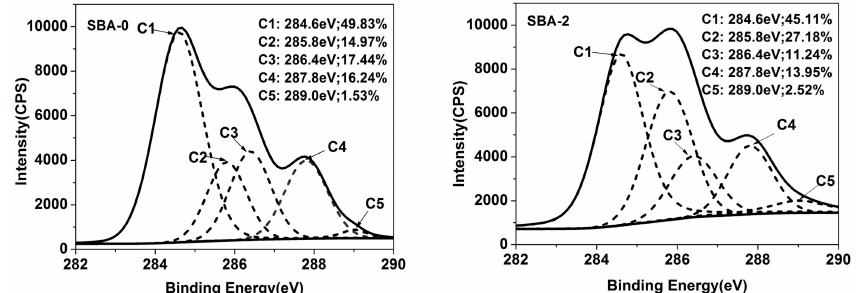
Figure 2. XPS spectra of cured SBA-0 and SBA-2 (N1: N–H/N–C; N2: C=N/N–C; N3: H–N–C(O)O/N–C=C; C1: C–C/C–H; C2: C–NH–C; C3: C–OH; C4: –NH–CO–/–CO(O)C–; C5:–COO–). XPS = X-ray photoelectron spectroscopy.